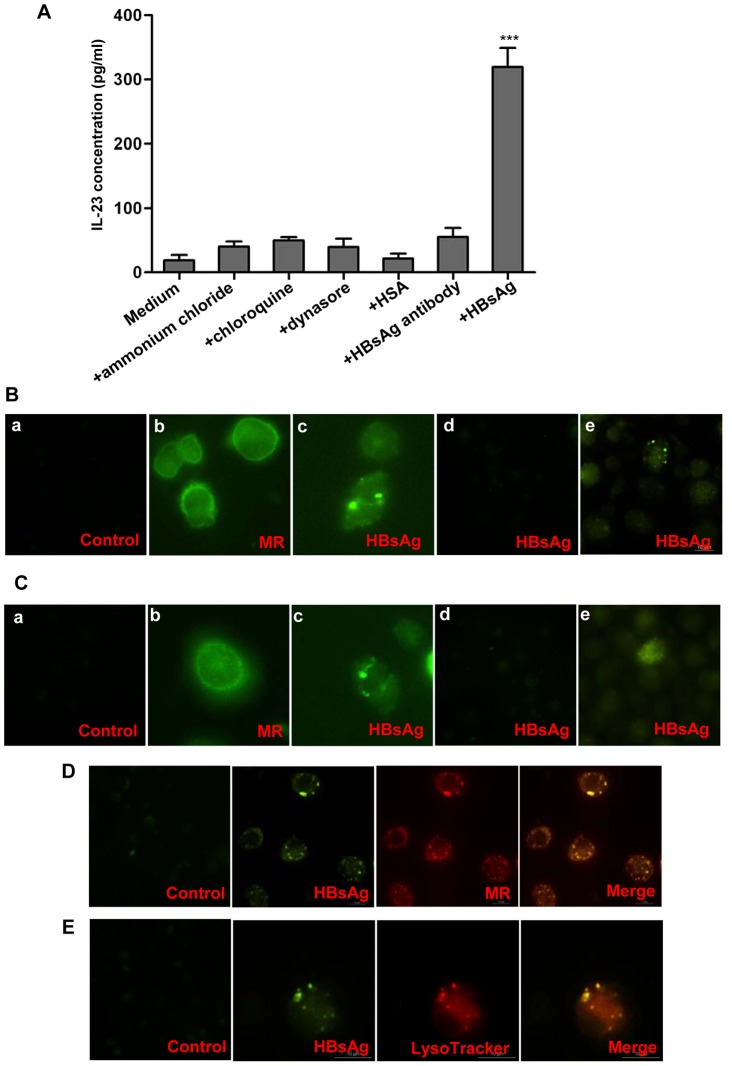
IL-23 production from DCs and macrophages stimulated by HBsAg is dependent upon endocytosis.(A) Monocytes were isolated from PBMCs of healthy blood donors and mDCs were induced by culturing in the presence of GM-CSF (50 ng/mL) and recombinant human IL-4 (5 ng/mL) for five days. Then, the mDCs were stimulated by HBsAg with or without ammonium chloride (10 µM), chloroquine (10 mM), Dynasore (80 µM), or HBsAg antibody (50 µg/mL) for 40 hours. ELISA was used to detect the concentration of IL-23 in the supernatants. The data represent one of three independent experiments with similar results. Error bars indicate SD. ***P<0.001 vs. all other groups. DCs (B) and macrophages (C) were obtained from PBMCs for different stimulations and stainings. (a) Cells were stimulated with HBsAg (2 µg/mL) for 45 min and stained by isotype IgG (FITC). (b) Cells were directly stained with anti-MR mAb (FITC) without any stimulations. (c) Cells were stimulated with HBsAg (2 µg/mL) for 45 min and stained by anti-HBsAg mAb (FITC). (d) Cells were pretreated with MR-blocking antibody (10 µg/mL) for 30 min before the cells were stimulated by HBsAg (2 µg/mL) for 45 min and stained with anti-HBsAg (FITC). (e) Cells were pretreated with chloroquine (10 mM) for 10 min before stimulation by HBsAg (2 µg/mL) for 45 min and staining with anti-HBsAg (FITC). mDCs were stimulated by HBsAg (2 µg/mL) for 45 minutes, and the respective co-localizations of HBsAg with MR (D) or endosomal marker LysoTracker (E) were detected by confocal microscopy. (magnification 400×).